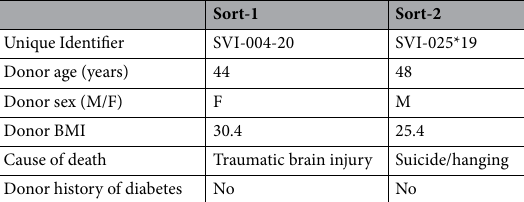
Table 2. Information for donor material used in flow sorting